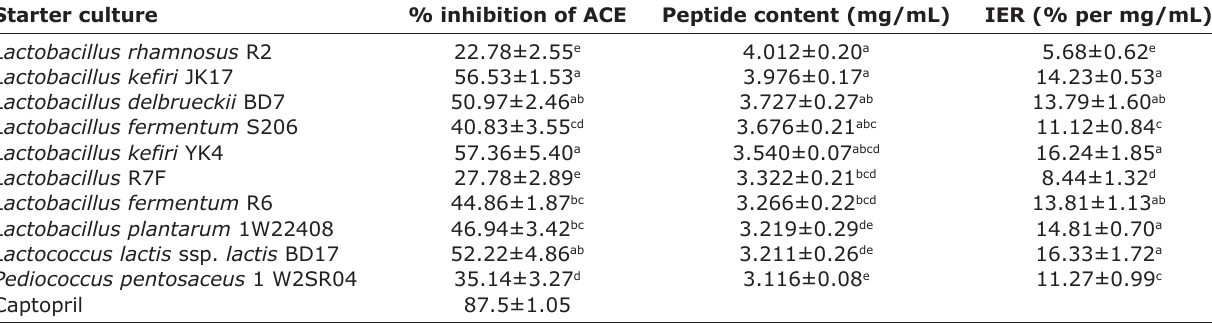
Table-2: ACE-inhibitory, peptide content, and IER in milk fermented by ten LAB cultures after reaching pH 4.6 incubated at 37°C. Starter culture